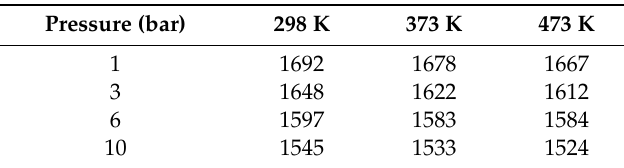
Table 9. The calculated adiabatic flame temperature (CAFT) at the experimentally determined UFL of methane-air mixtures at di ff erent initial pressure and temperatures. Reproduced from Ref. [84], Elsevier B.V.: